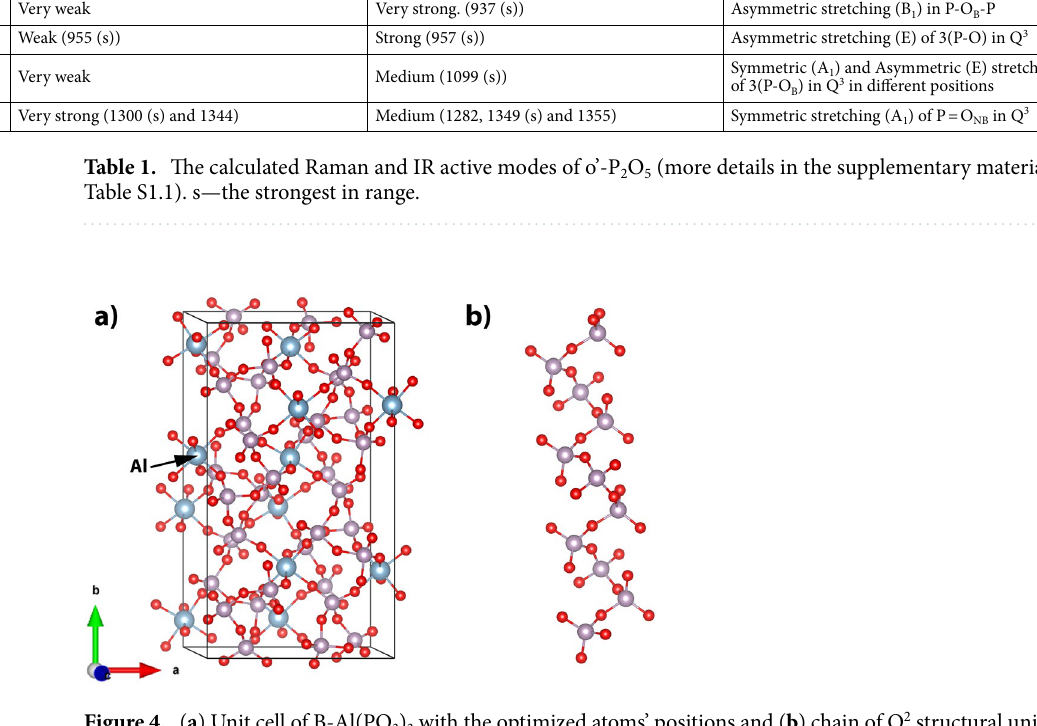
Figure 4. ( a ) Unit cell of B-Al(PO 3 ) 3 with the optimized atoms’ positions and ( b ) chain of Q 2 structural